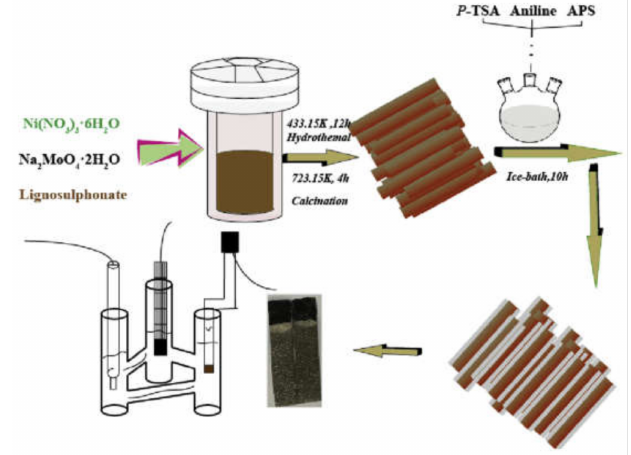
Figure 16. Schematic representation of the preparation and electrochemical system of the NiMoO 4 - PANI polymer nanocomposite. Reproduced with permission from [230]. Elsevier, 2018.